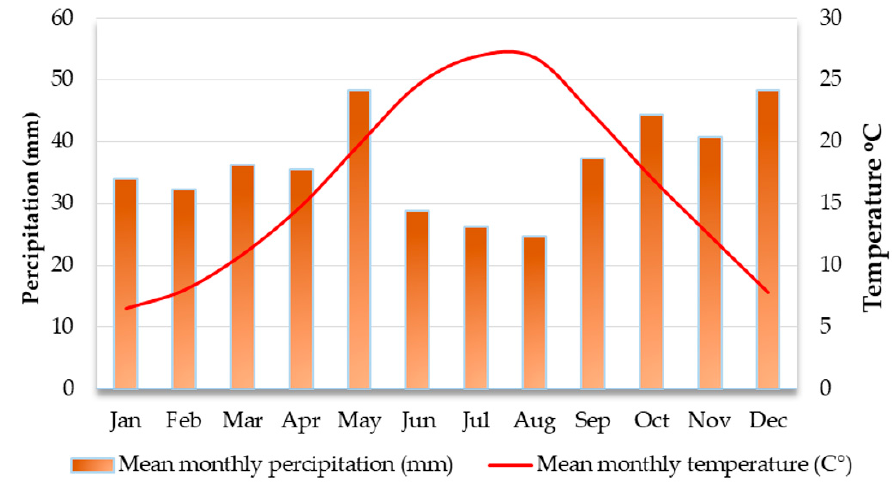
Figure 8. The climate in Thessaloniki, as depicted by the Bangouls and Gaussen rain–temperature diagram, is characterized by a dry thermal period that starts in June and lasts until early October. This pattern represents the typical weather conditions in the region and helps to provide an understanding of the area’s climate dynamics.